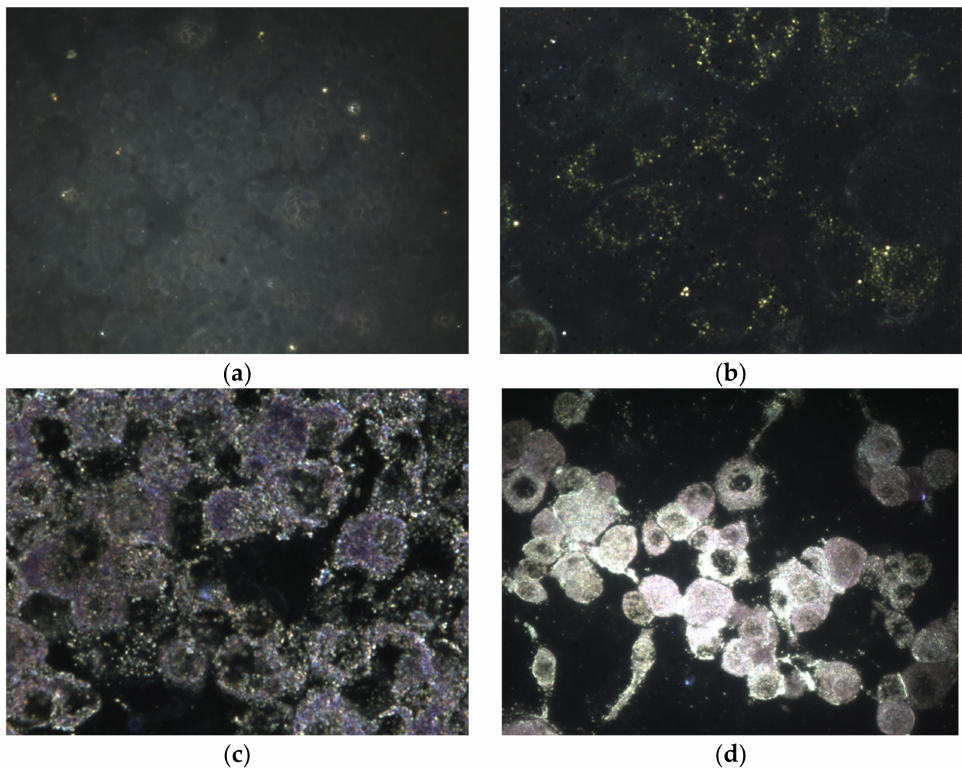
Figure 6. Cells (macrophages) exposed to various drug quantities: ( a ) Stage A—Control; ( b ) Stage B—12.5 µ g/mL; ( c ) Stage C—25 µ g/mL; ( d ) Stage D—50 µ